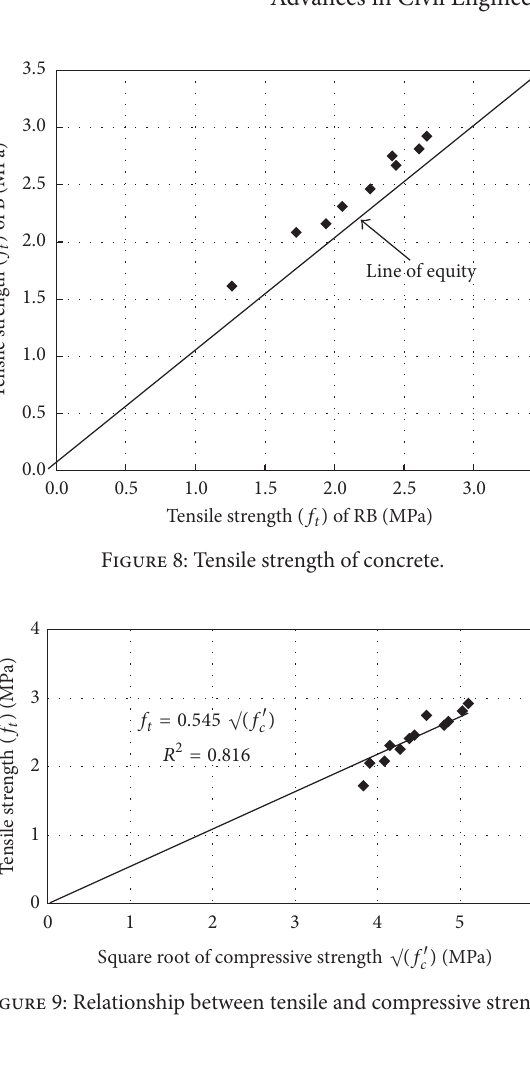
Figure 7: Relationship between NDT and DT.